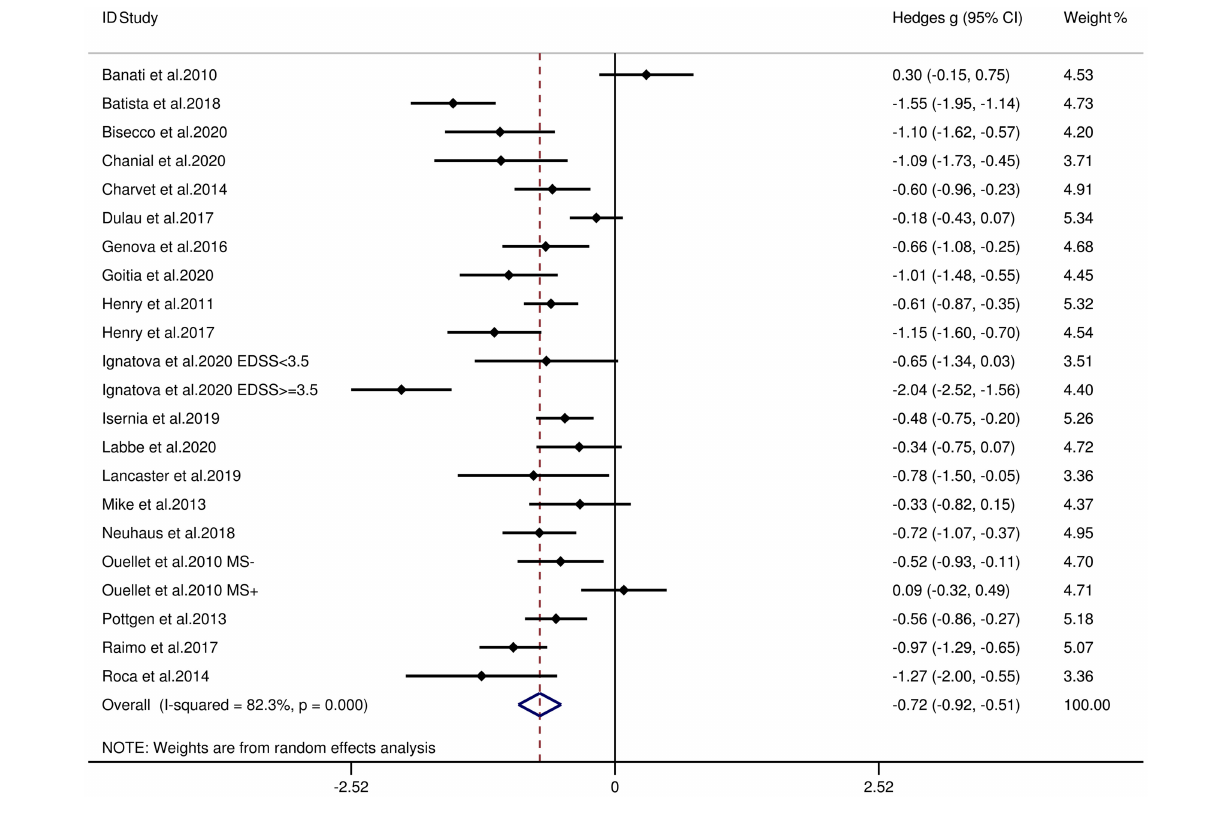
FIGURE 4 | Forest plots showing effect size estimates (Hedges g) for cognitive ToM differences between MS and healthy controls. CI, confidence interval; MS, multiple sclerosis; ToM, theory of